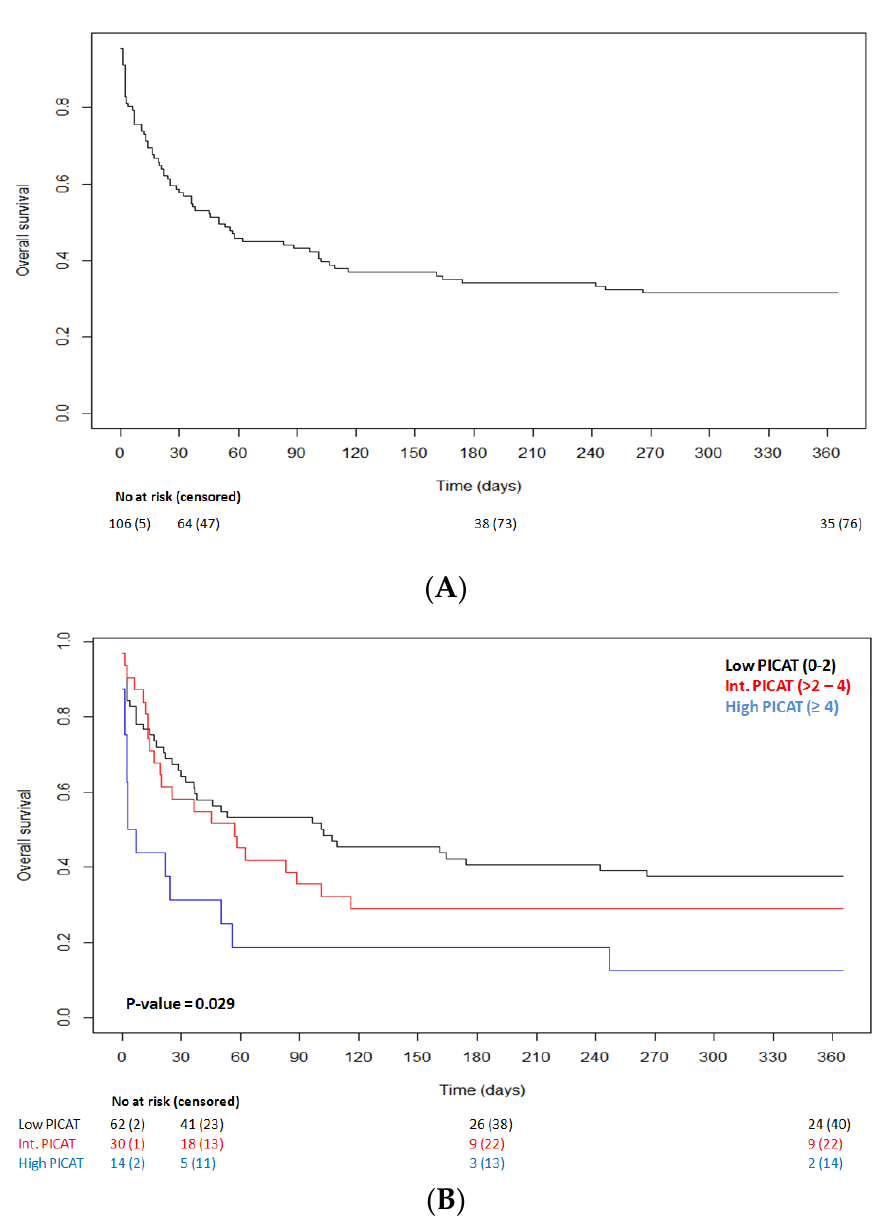
Figure 1. ( A ) Kaplan–Meier curve of overall survival after admission in ICU. Thirty-day OS is 57.7%, and 1-year OS is 31.5%. ( B ) Kaplan–Meier curve of OS according to PICAT classes (10); low in black ( n = 64), intermediate in red ( n = 31), and high in blue ( n = 16); p -value = 0.029. In univariate Cox analyses, PICAT score ( p = 0.036), platelet transfusion requirement before ICU admission ( p = 0.0065), HLA—haplo-identical donor ( p = 0.033), and disease relapse before ICU admission ( p = 0.0001) predicted mortality. There was a similar trend for carrying MDR bacteria at ICU admission ( p = 0.075) (Table 3). In contrast, the time period of ICU admission did not significantly correlate with mortality in our cohort ( p =